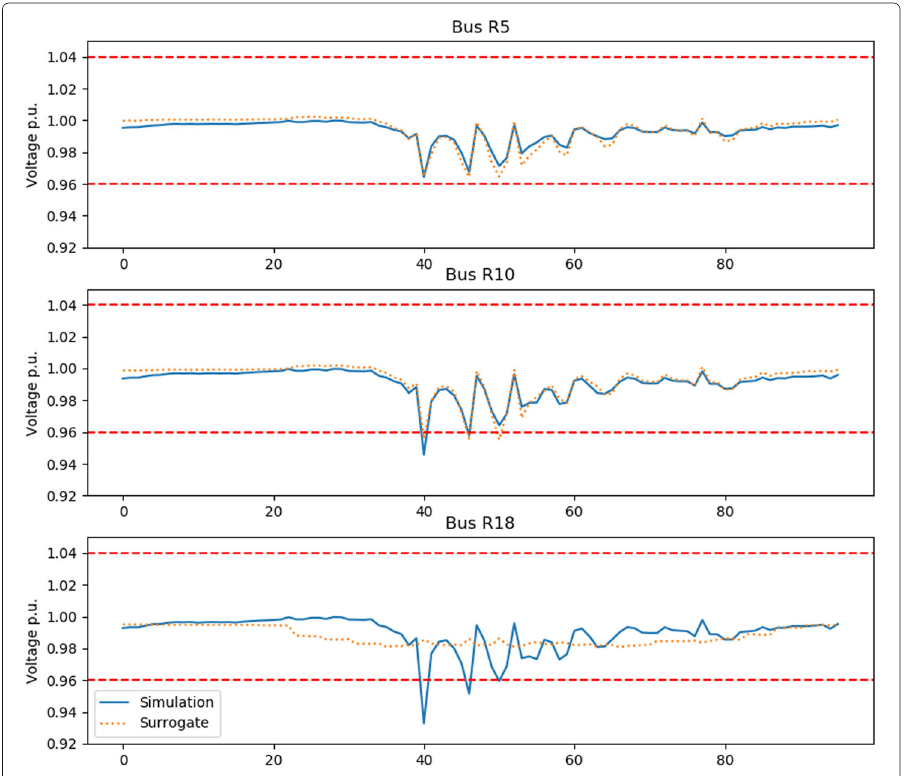
Fig. 12 Simulation results for buses R5, R10, and R18. Visually, the match between simulation model and surrogate model at buses R5 and R10 is quite good. The third graph reveals that the surrogate model has fundamental problems to reproduce the results for bus R18, which could be a reason for the bad recall rating